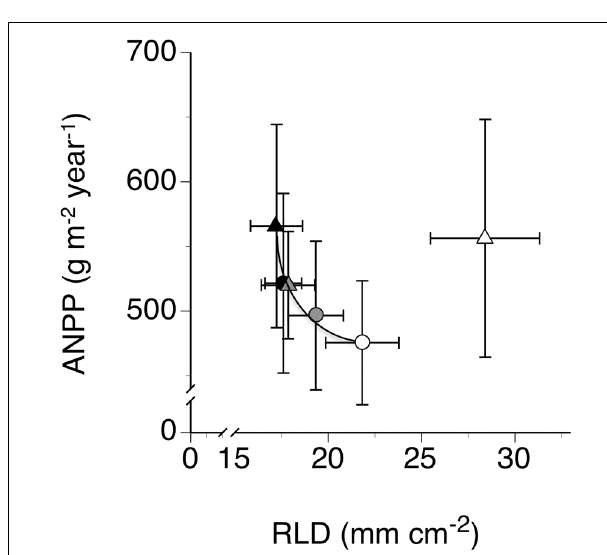
FIGURE 4 | Relationships between mean annual aboveground plant biomass production (ANPP) and mean annual root length density (RLD) in trenched grassland plots with manipulated earthworm densities (EWDs) under ambient and increased rainfall (means ± SEs, n = 5 plots per experimental treatment) analyzed using both simple linear regression and exponential best fit algorithms (see Materials and Methods) of mean treatment values but excluding the treatment mean for the low EWD and increased rainfall (upper rightmost point). Symbology for treatments given in the legend to Figure 1